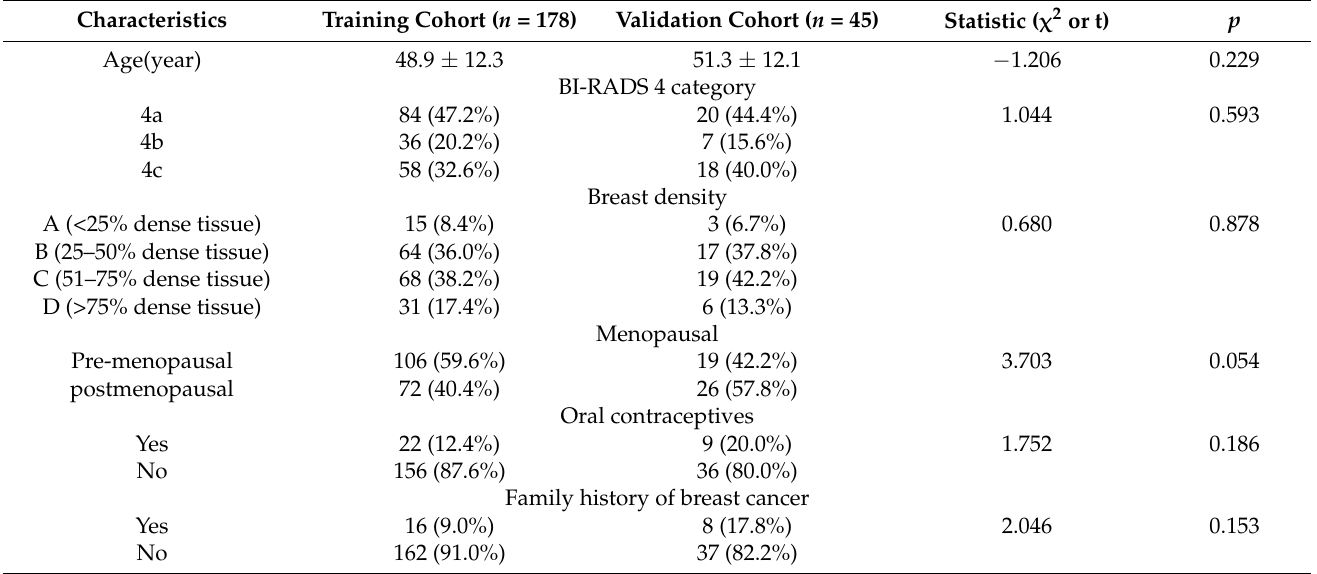
Table 1. Clinical basic characteristics and ultrasound features in training and validation